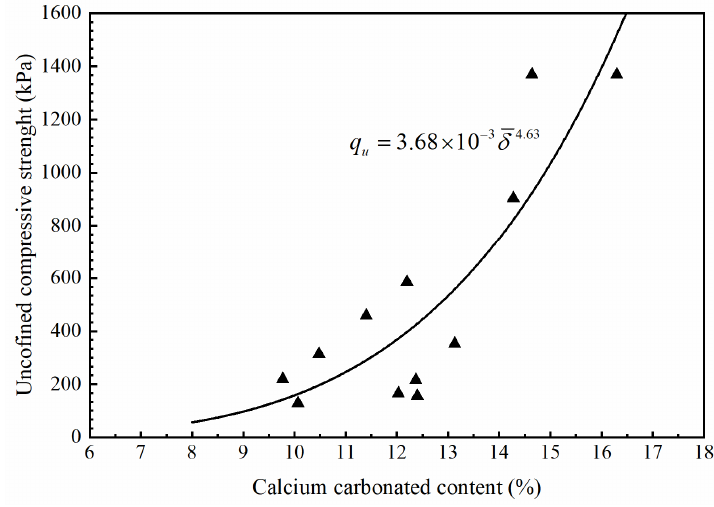
Figure 9. Relationship between the unconfined compressive strengths and average calcium carbonate content.